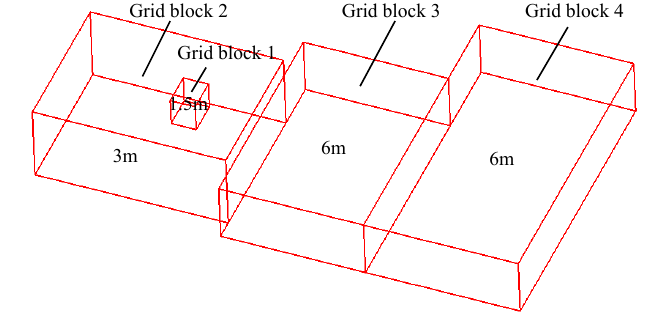
Figure 10. Mesh scheme application for engineering. The size of block 1: 130 m × 170 m × 150 m; the size of block 2: 1000 m × 750 m × 400 m; the size of block 3: 750 m × 1100 m × 300 m; the size of block 4: 800 m × 1500 m × 300